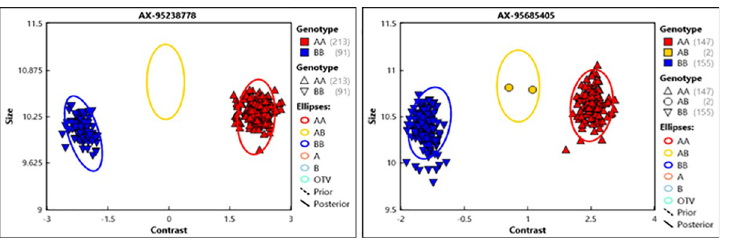
Fig 3. Examples of cluster plots of durum association panel resulted from axiom analysis suit V.2 with best practice workflow. QC Threshold passed accessions are 296 and 8 samples are control; AX-95238778 & AX-95685405 are Axiom SNP probes with which the accessions are